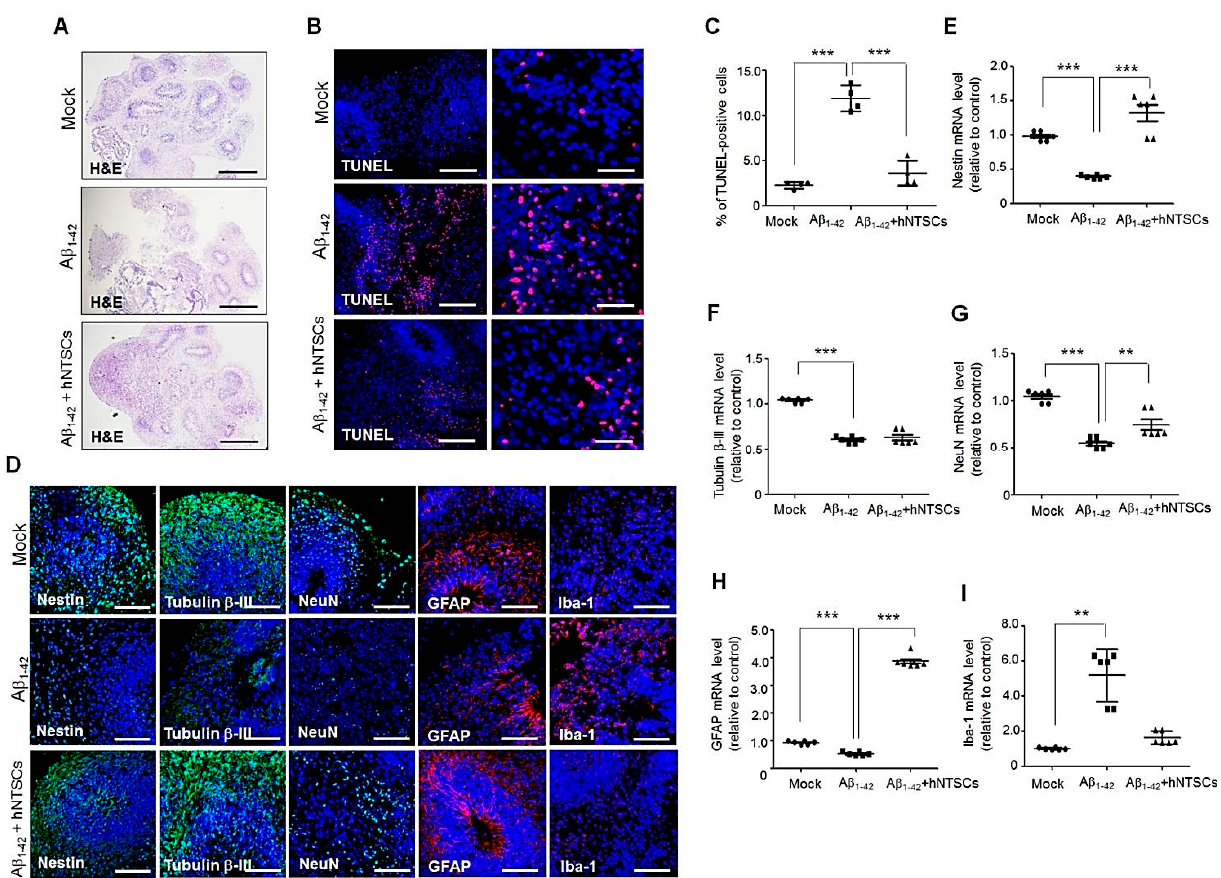
Figure 3. Histological analysis of hBOs cultured in the presence of A β 1–42 with hNTSC coculture. ( A ) H&E images of hBOs cultured in the absence or presence of 10 μ M A β 1–42 with hNTSC coculture for 72–80 h after staining of OCT-embedded sections. Scale bar: 200 μ m. ( B ) Confocal microscopy images of hBOs after staining OCT-embedded sections with a TUNEL assay kit (red). The hBOs were cultured in the absence or presence of 10 μ M A β 1–42 with hNTSC coculture for 72–80 h. Scale bars: 200 μ m, 50 μ m. ( C ) TUNEL-positive cells were counted in hBOs cultured in the absence or presence of 10 μ M A β 1–42 with hNTSC coculture for 72–80 h. The values shown are the mean (SD). For nonparametric multiple comparison tests, one-way ANOVA was used to determine whether differences between groups were statistically significant. *** p < 0.001. ( D ) Confocal microscopy images of hBOs cultured in the absence or presence of 10 μ M A β 1–42 with hNTSC coculture for 72–80 h after staining of OCT-embedded sections with antibodies against Nestin, Tubulin β -III, NeuN (green), GFAP (red), and Iba-1 (red). Nuclei were labeled with DAPI (blue). Scale bars: 200 μ m or 20 μ m. ( E – I ) Nestin, Tubulin β -III, NeuN, GFAP, and Iba-1 mRNA levels were measured by quantitative real-time PCR after 72–80 h of culture in hBOs cultured in the absence or presence of 10 μ M A β 1–42 with hNTSC coculture. The GAPDH gene was used as a control. The values shown are the mean (SD). For nonparametric multiple comparison tests, one-way ANOVA was used to determine whether differences between groups were statistically significant. ** p < 0.01,*** p < 0.001. All data are representative of two or three independent experiments.